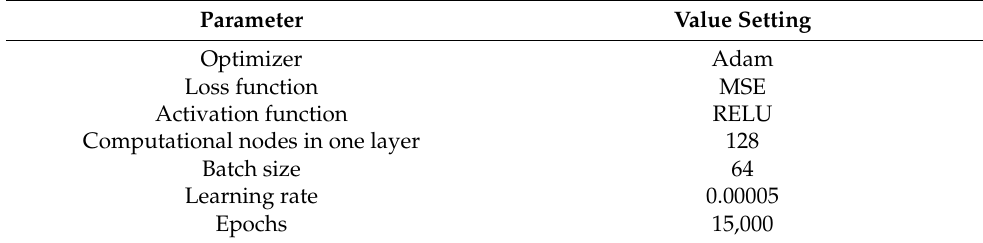
Figure 8. RMSEs of the training performance versus the training epochs. Table 1. Parameter settings for the LSTM-RNN.